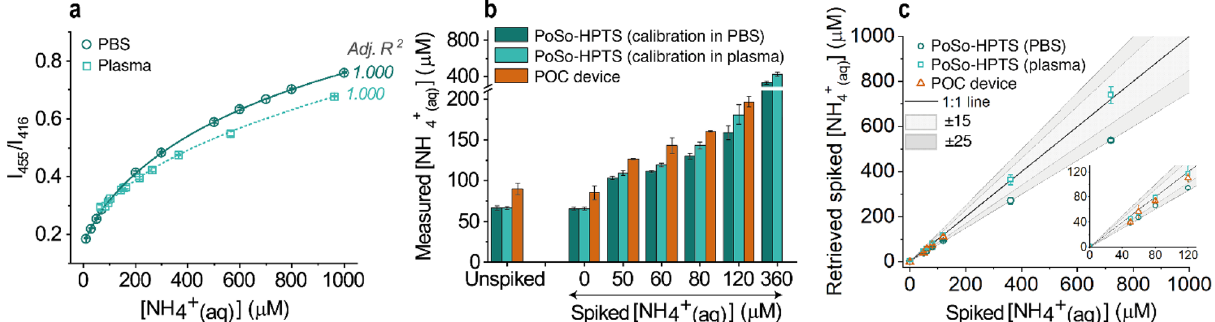
Figure 6. Ammonia measurements in plasma with PoSo-HPTS and a POC device. ( a ) Ammonia sensing calibration curves obtained with sigmoidal regression fit of the measured fluorescence intensity ratio I 455